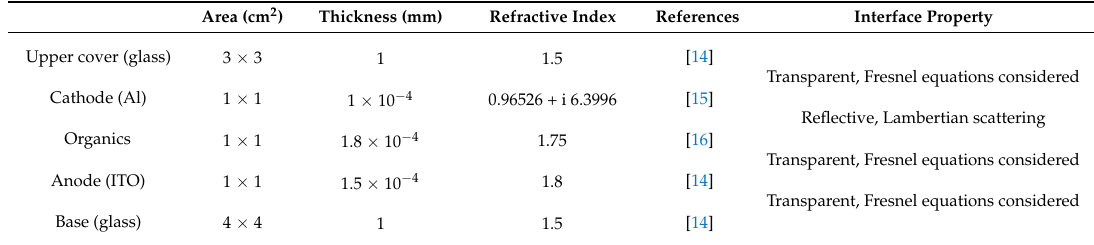
Table 1. Dimensions and optical properties of the